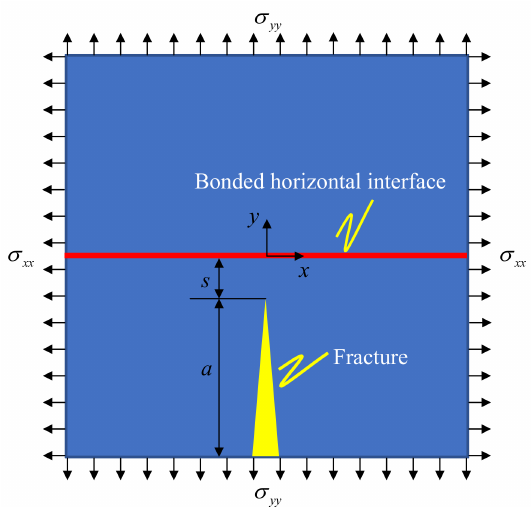
Figure 6. Model used to simulate a vertical opening fracture approaching a horizontal bonded interface.